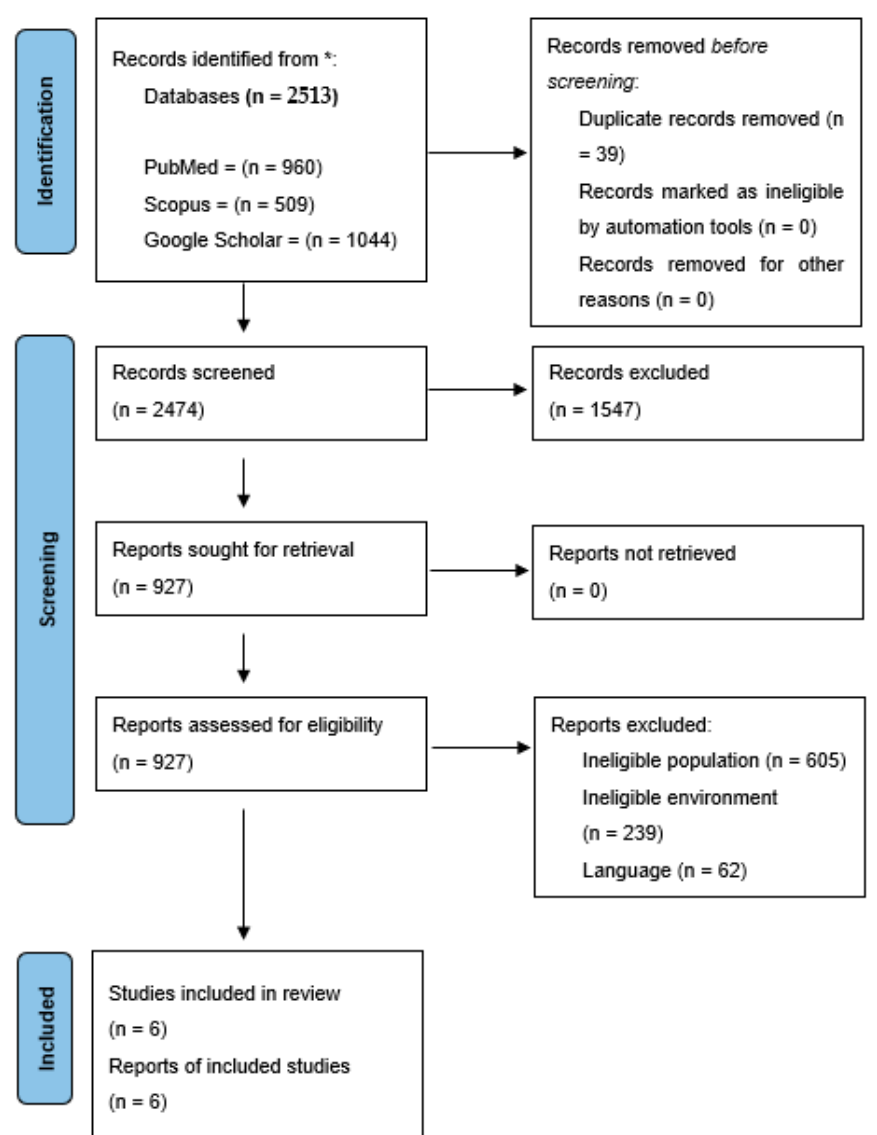
Figure 1. Preferred Reporting Items for Systematic Reviews and Meta-Analyses (PRISMA) flow